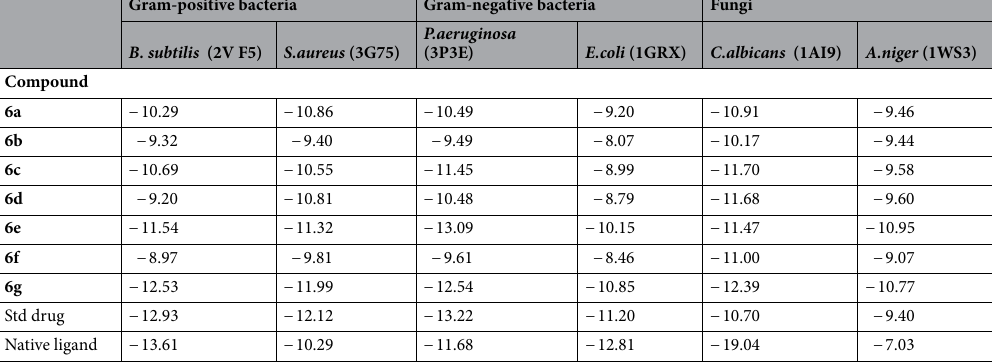
Table 7. Binding free energy (ΔG) of the compounds. Standard drugs: ciproflocin and